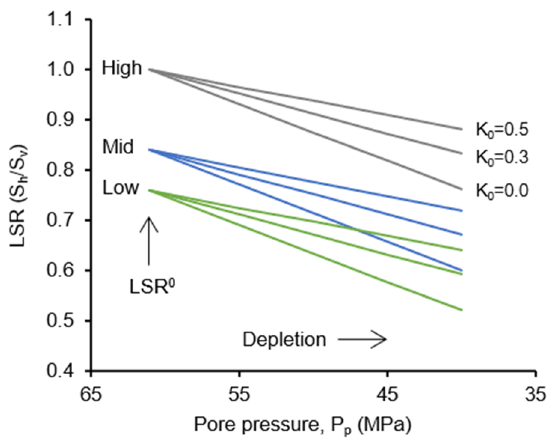
Figure 6. LSR evolution with reservoir depletion assuming different stress paths.